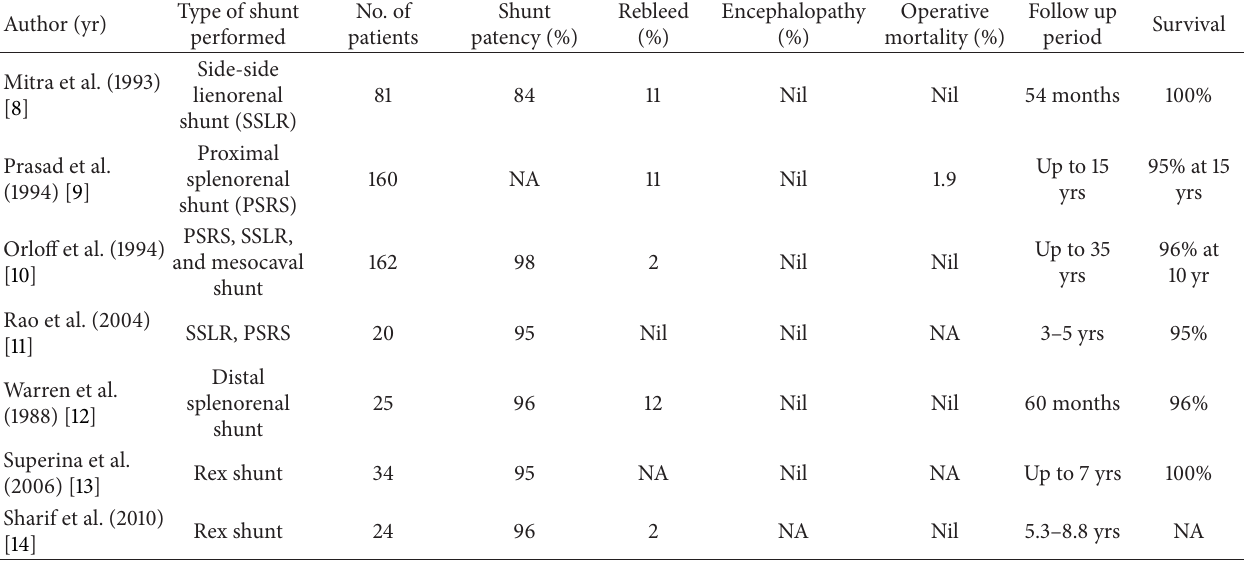
Table 2: Outcomes of different shunt surgeries in